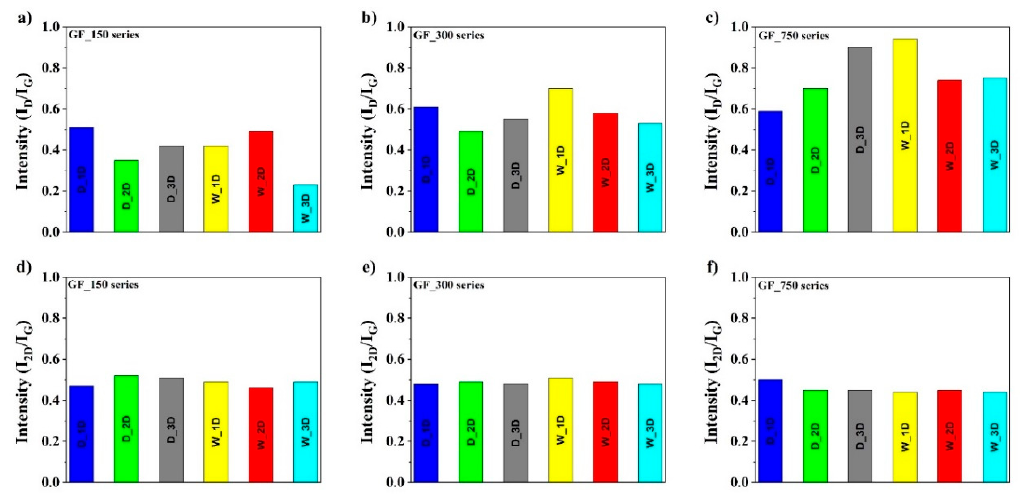
Figure 4. The ratio of the intensities between the D, G and 2D bands: ( a ) I D / I G of GF_150 D and W series, ( b ) I D / I G of GF_300 D and W series, ( c ) I D / I G of GF_750 D and W series, ( d ) I 2D / I G of GF_150 D and W series, ( e ) I 2D / I G of GF_300 D and W series and ( f ) I 2D / I G of GF_750 D and W series.